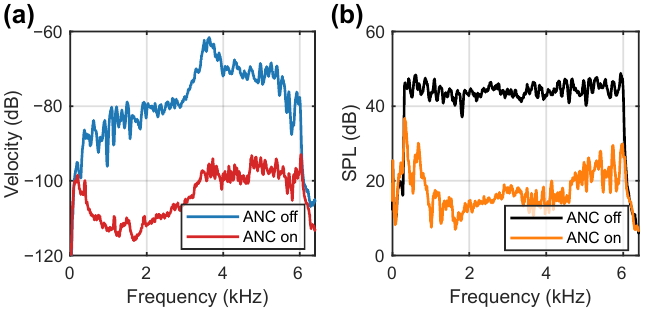
Figure 13. Spectra of ( a ) the membrane velocity and ( b ) the corresponding sound pressure level (dB re 20 µPa) observed by the HATS without and with ANC for a grey noise from 300 Hz to 6 kHz.